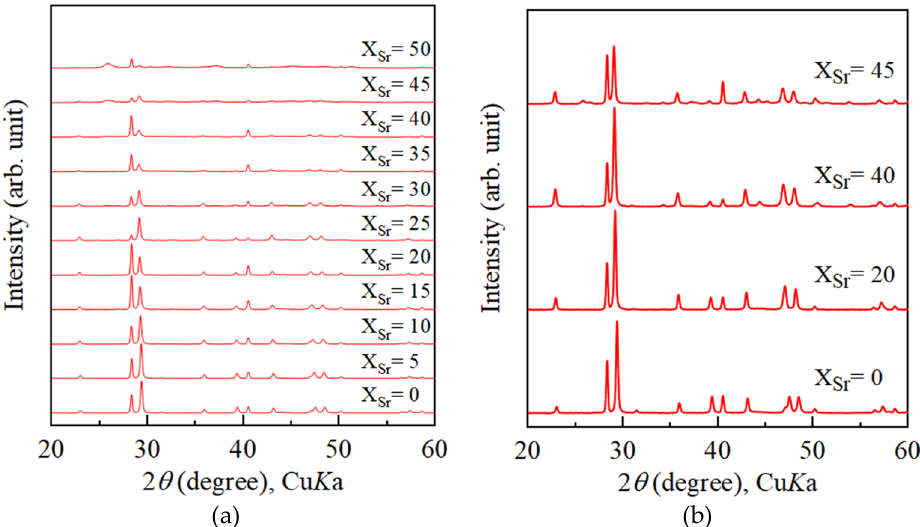
Figure 1. Powder X-ray diffraction patterns of calcium carbonate samples precipitated from solutions with various Sr concentrations. ( a ) Crystallization was induced by pressure treatment. ( b ) Powder X-ray diffraction patterns of calcium carbonate samples precipitated from solutions with various Sr concentrations. Crystallization was induced by heating treatment at 400 °C for 2 h. x Sr stands for Sr/(Sr + Ca) of starting solutions.